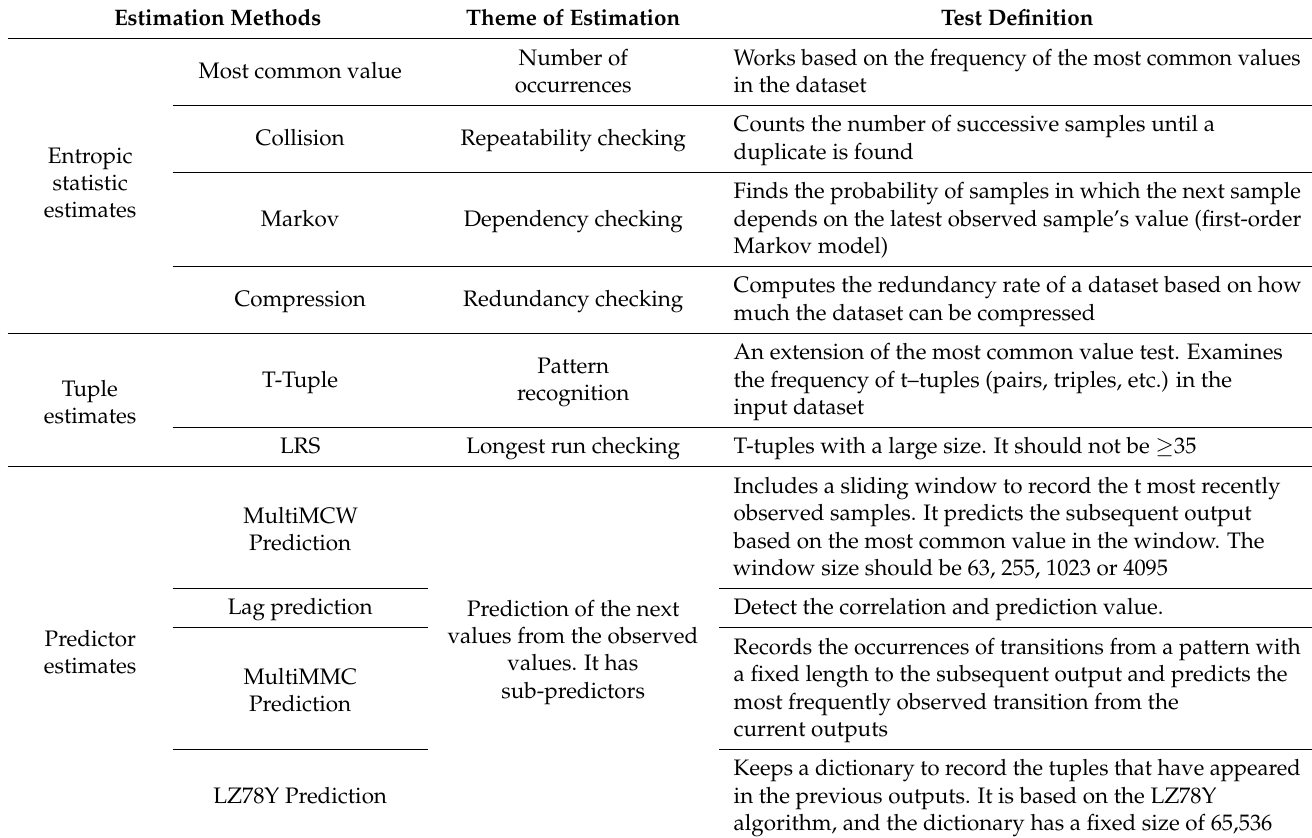
Table 3. List of NIST SP 800-90B estimators and their explanations